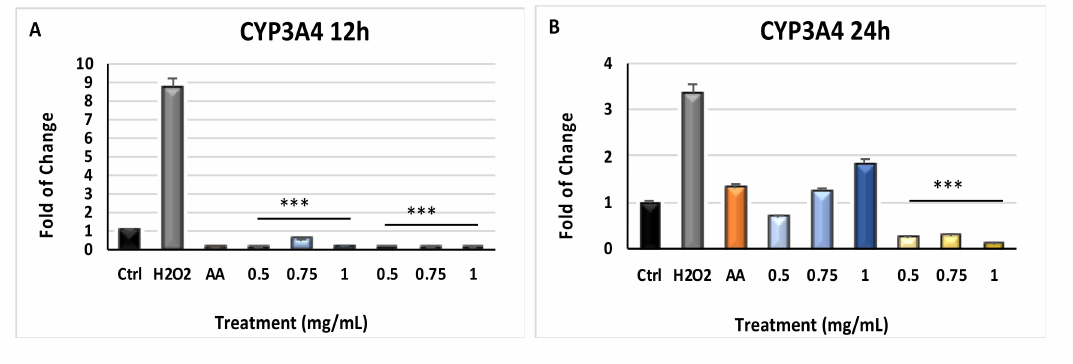
Figure 4. CYP3A4 gene expression. The expression of CYP3A4 was evaluated in cells cultured for 12 h and 24 h (Panels ( A , B )) in the presence of di ff erent concentrations of pulp and seeds extracts, and then exposed to H 2 O 2 . HFF1 were exposed to ascorbic acid (AA, orange bar), or to 0.5, 0.75 and 1 mg / ml seeds waste extracts (blue bars) or 0.5, 0.75 and 1 mg / mL pulp waste extracts (yellows bar). H 2 O 2 (grey bar) represents HFF1 cells exposed to only H 2 O 2, without previous extracts treatment. The mRNA levels for each gene was expressed as fold of change (2 − ∆∆ Ct ) of mRNA levels observed in untreated HFF1 (CTRL, black bar) defined as 1 (mean ± SD; n = 6) and normalized to Glyceraldehyde-3-Phosphate-Dehidrogenase (GAPDH). Data are represented as mean ± SD referred to the control (* p ≤ 0.05, ** p ≤ 0.01 and *** p ≤ 0.001).